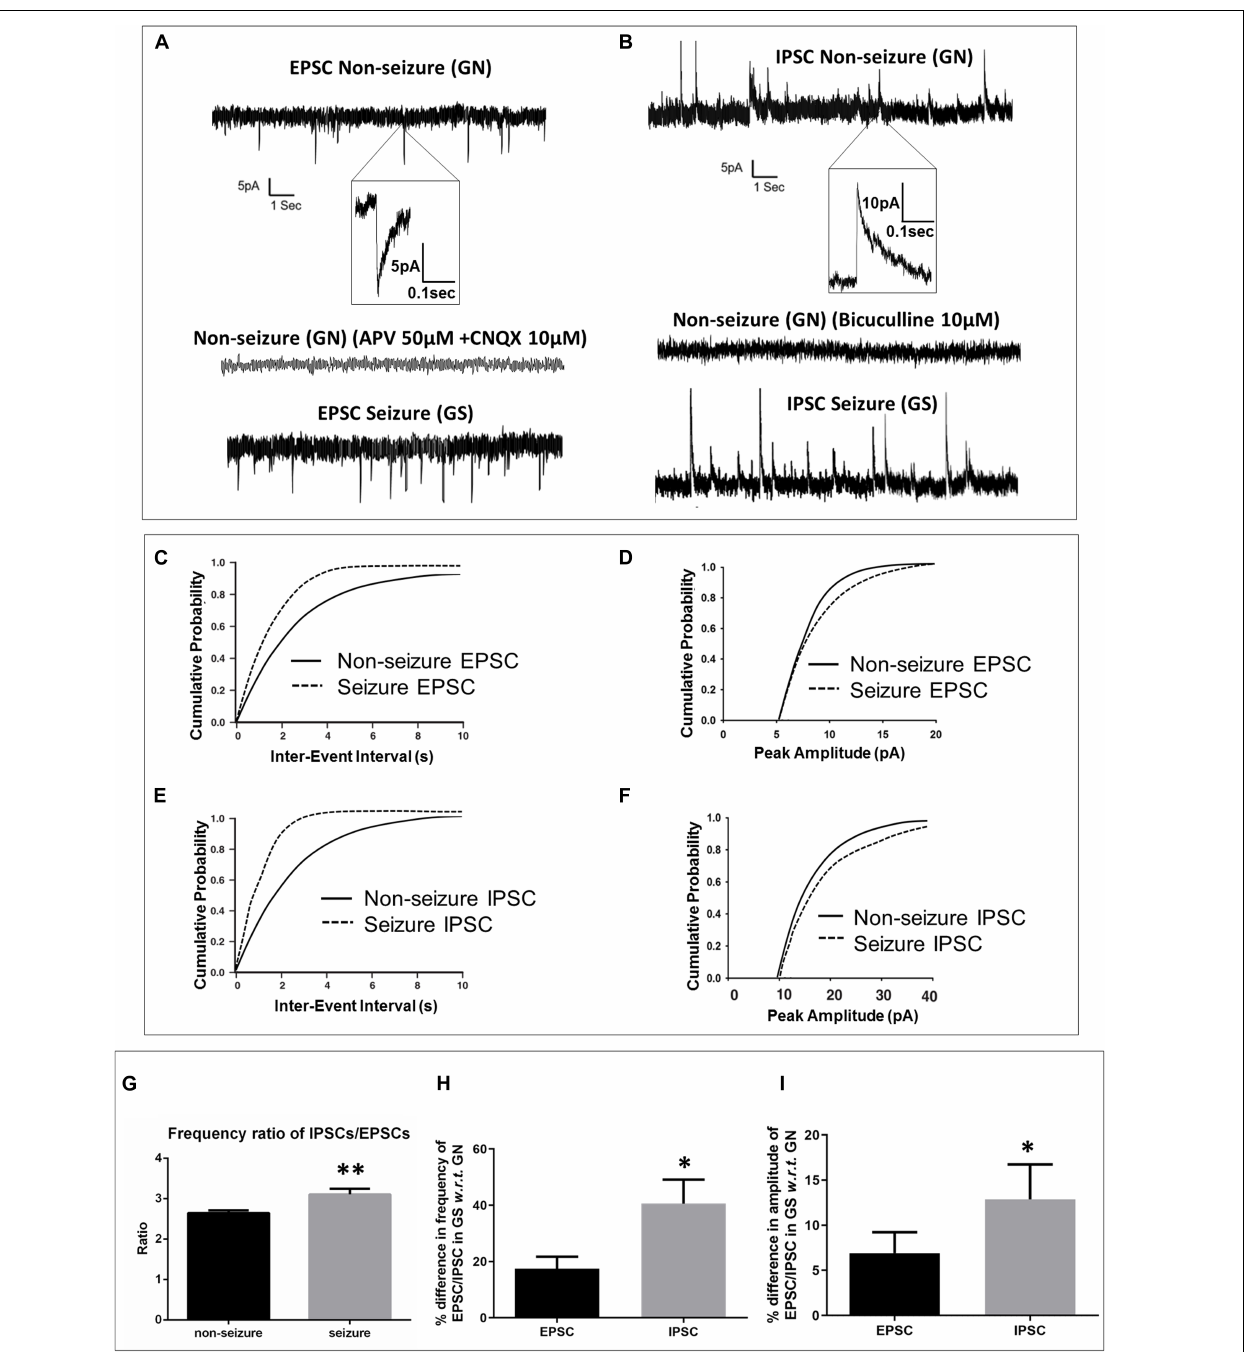
FIGURE 2 | Spontaneous excitatory and inhibitory postsynaptic currents were enhanced in glioma patients with a history of seizures (GS). (A) Sample recordings of spontaneous excitatory postsynaptic currents (EPSCs) recorded from pyramidal neurons in the peritumoral sample obtained from glioma patients without history of seizures (GN). The inset shows a single EPSC event at an expanded time scale. The second trace shows the absence of any spontaneous EPSC following perfusion of the slice with glutamate receptor antagonists APV (50 µ M) and CNQX (10 µ M) for 10 min, proving that these events are mediated by glutamate receptors. The bottom trace shows sample recordings of spontaneous EPSCs recorded from pyramidal neurons in the peritumoral sample obtained from GS patients. The plots represent data from 15 neurons from 15 patients for GN ( n = 15) and 11 neurons from 11 patients for GS ( n = 11). (C) In GS patients, the cumulative distribution of inter-event interval displaced towards lower intervals ( p = 0.004; Kolmogorov–Smirnov test, K–S test), while that of (D) peak amplitude displaced towards larger amplitudes ( p = 0.026; K–S test). (B) Sample recordings of spontaneous inhibitory postsynaptic currents (IPSCs) recorded from pyramidal neurons in the peritumoral sample obtained from GN patients. The inset shows a single IPSC event at an expanded time scale. The second trace shows the absence of any spontaneous IPSC